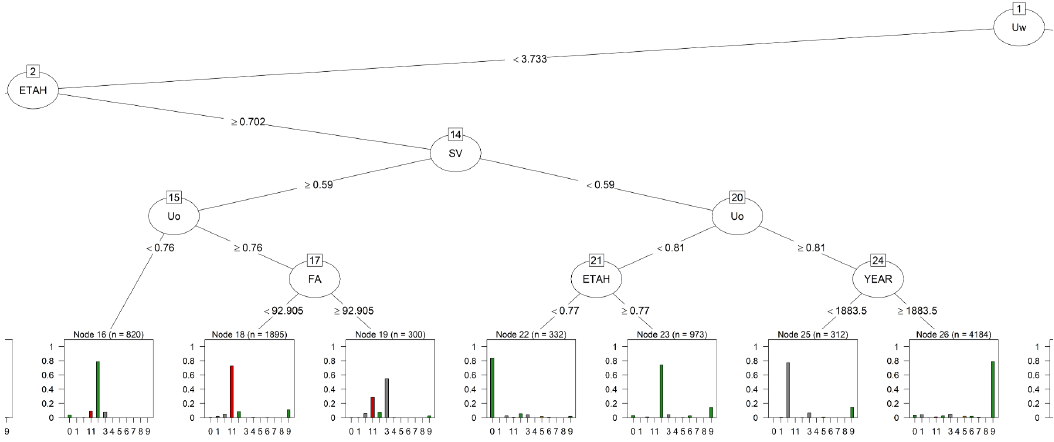
Figure 3. Example of CART generated by the